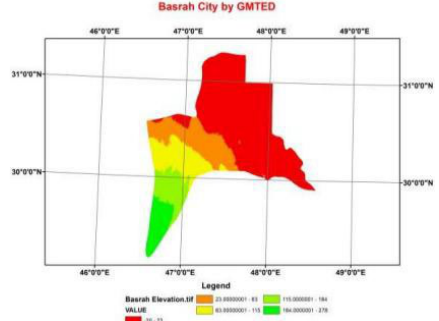
Figure 4. GMTED2010 elevation model for Basrah